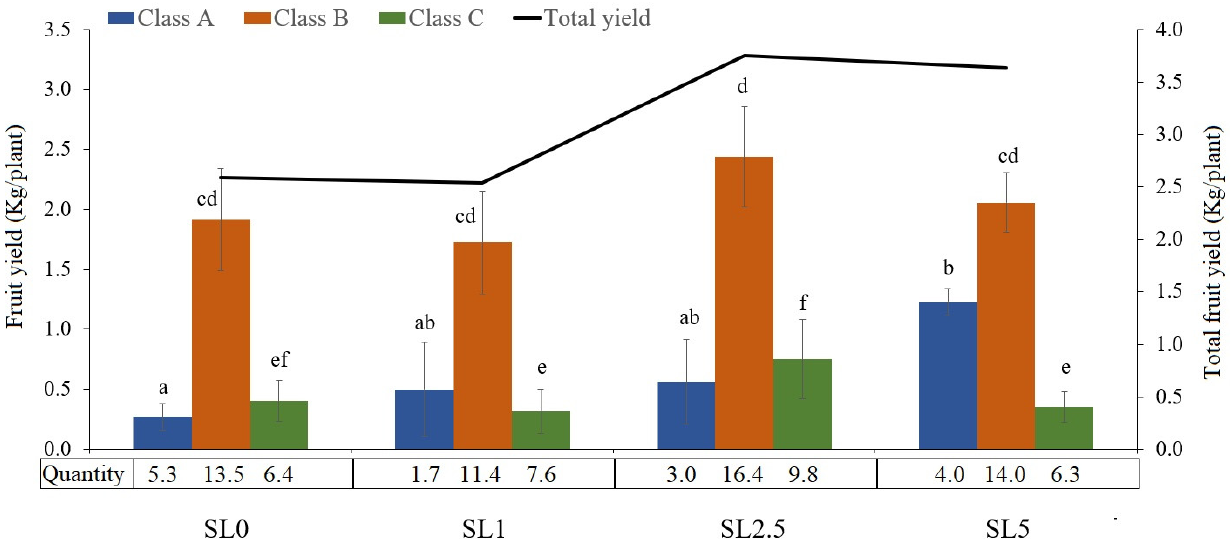
Figure 7. Average weight yield of tomatoes per plant for three biochar treatments of the silty loam (SiL) and sandy loam (SL), according to tomato size class, harvested in eight weeks. Tomatoes were classified as class A (>200 g), class B (100–200 g), and class C (<100 g). Continuous black line represents the total tomato yield for each treatment. Average fruit quantity per plant is reported in the x axis. Different letters indicate significant differences ( p <